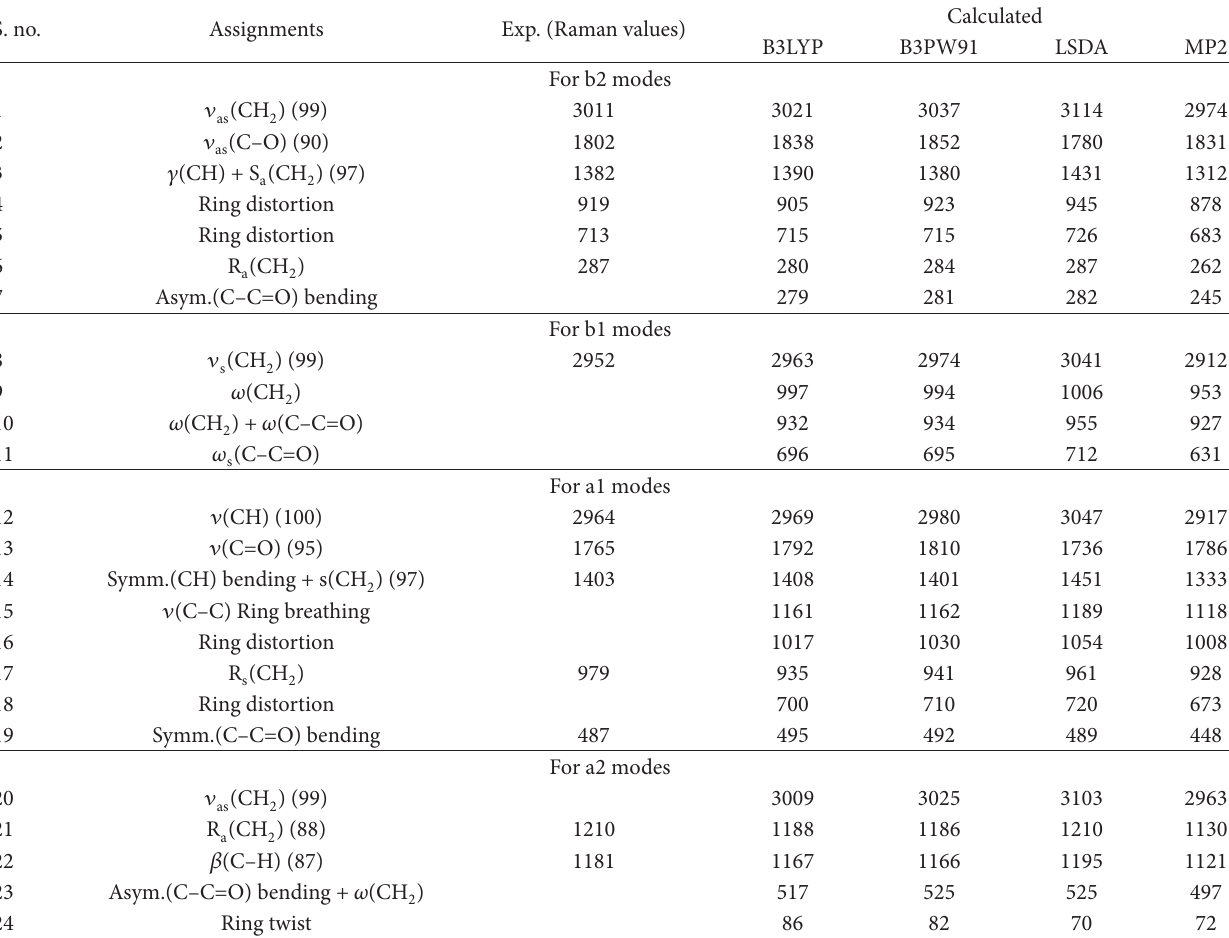
1 ) with PED contribution of − %